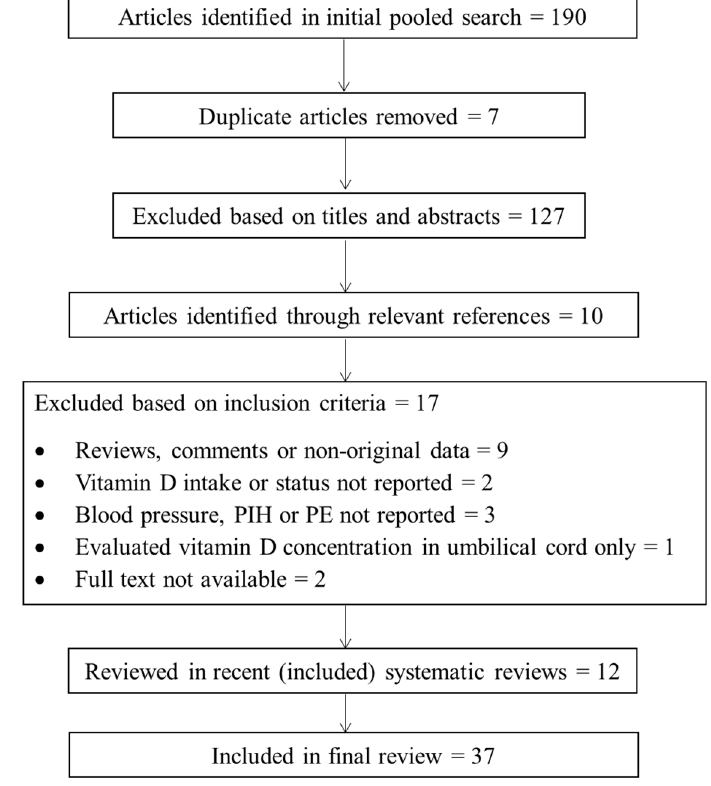
Figure 1. Flowchart of the search strategy and selection process.